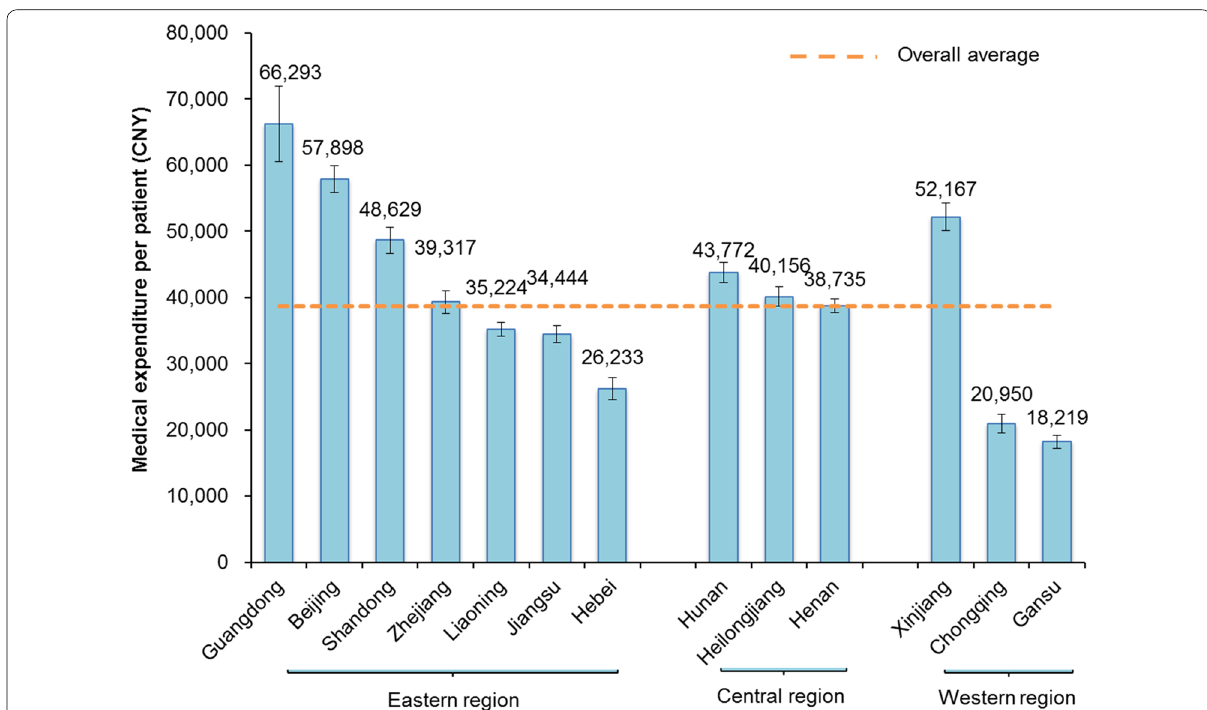
Fig. 1 Medical expenditure for esophageal cancer diagnosis and treatment per patient in China, by province/municipality. China is divided into the eastern, central, and western regions. Guangdong, Beijing, Shandong, Zhejiang, Liaoning, Jiangsu, and Hebei belong to the eastern region of China; Hunan, Heilongjiang, and Henan belong to the central region of China; and Xinjiang, Chongqing, and Gansu belong to the western region of China. Each bar indicates the average expenditure with 95% confidence interval in